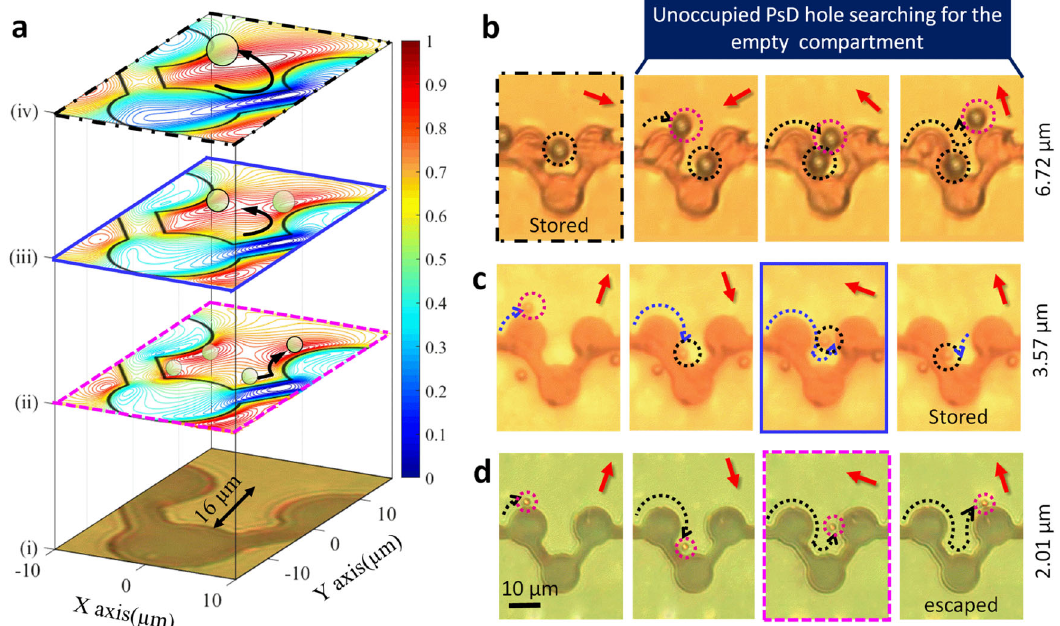
Fig. 8 Individual storage capacitors of PsD holes. a Simulated potential energy distributions considering the depth of the U-shaped storage apartment (i) and the diameter of PsD holes: (ii) 2.01 µ m, (iii) 3.57 µ m (iv), and 6.72 µ m. The potential energy planes plotted at different heights from the pattern surface. b Individual storage apartments having a single maximum potential energy occupied with a 6.72 µ m PsD hole. Due to the magnetic coulomb-like interaction between two holes, an unoccupied PsD hole recognizes the occupied apartment and further navigates to the search for an empty apartment. c A 3.57 µ m PsD hole permanently stored and moving back and forth between two maximum potential energy peaks inside the individual compartment. d PsD holes 2.01 µ m in diameter that escaped from the storage compartment due to the movement of potential energy along the pattern boundary under rotating fi elds.